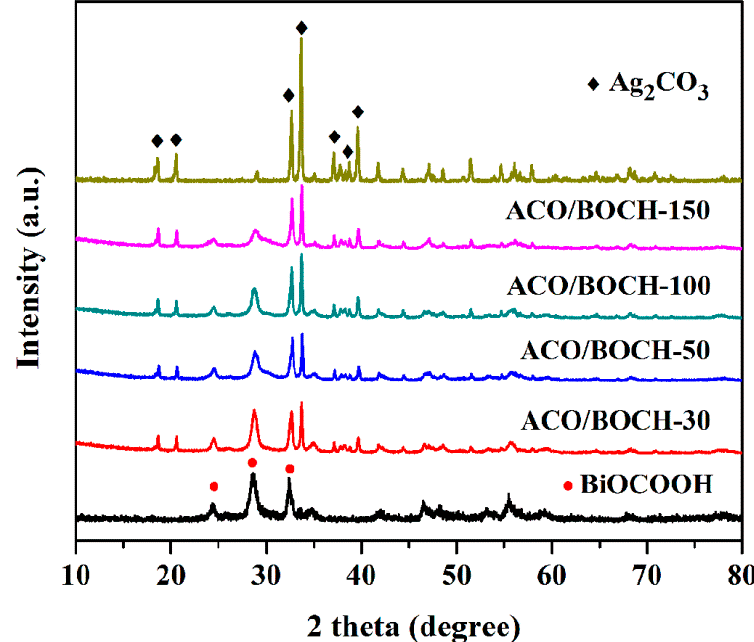
Figure 1. XRD patterns of pure BiOCOOH, Ag 2 CO 3 , and Ag 2 CO 3 /BiOCOOH heterojunctions (ACO/BOCH-30, ACO/BOCH-50, ACO/BOCH-100, and ACO/BOCH-150).